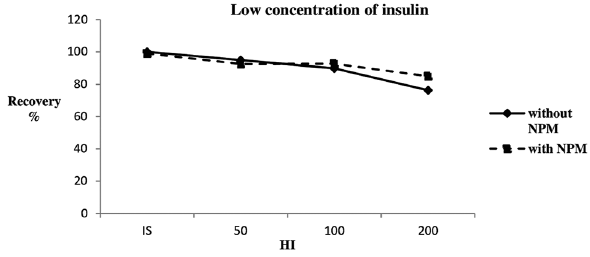
Figure 3: Low concentration of insulin recovery graphic between without NPM and with NPM groups. In the group without NPM, insulin concentration in 100 and 200 HI decreased to 89 and 76%, respectively.